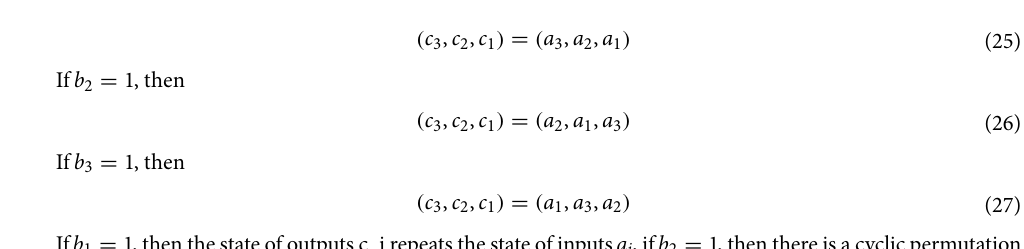
Figure 4. Schematic diagram of a direct multiplier (Image was generated in PowerPoint Microsoft 365 https:// www. micro soft. com/ en- ww/ micro soft- 365/ power